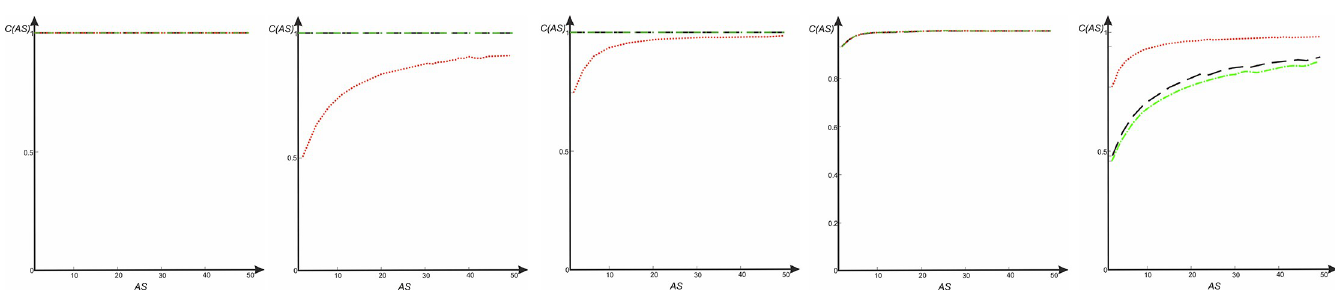
Fig 4. Dependence of the cross-correlation coefficient on the parameter AS for s- LASCA images of GB-speckles: Red dot lines—correlation between GB-speckles, generated for strain E/Bour, ST94 and for strain G/9301, ST 95, black dashed lines—correlation between GB-speckles, generated for strain E/Bour,ST94 and for strain G/11222,ST94, dash-dotted green lines—correlation between GB-speckles, generated for strain G/9301, ST 95 and for strain G/11222, ST94. (a) Cross- correlation coefficient CCC ( AS ) for gene gatA , cross-correlation coefficient CCC ( AS ) for gene gidA and cross-correlation coefficient CCC ( AS ) for gene enoA . (b) Cross-correlation coefficient CCC ( AS ) for gene fumC . (c) Cross-correlation coefficient CCC ( AS ) for gene hemN . (d) Cross-correlation coefficient CCC ( AS ) for gene hflX . (e) Cross-correlation coefficient CCC ( AS ) for gene oppA